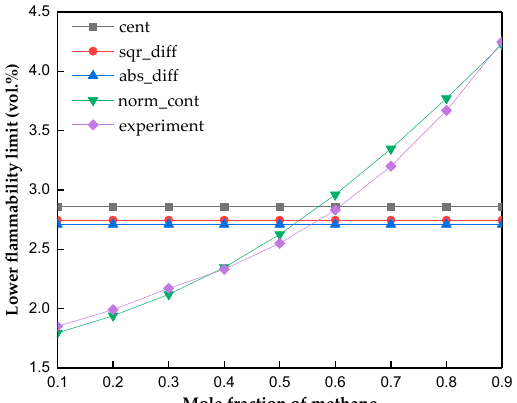
Figure 1. Experimental and predicted lower flammability limit (LFL) values for methane/butylene mixtures.